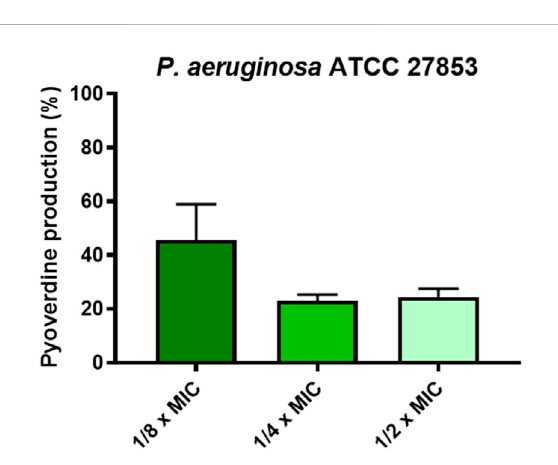
FIGURE 6 Percentage of pyoverdine production at 1/2, 1/4, and 1/8 x MIC of KDEON WK-11. Data represent the mean ± SEM of three independent